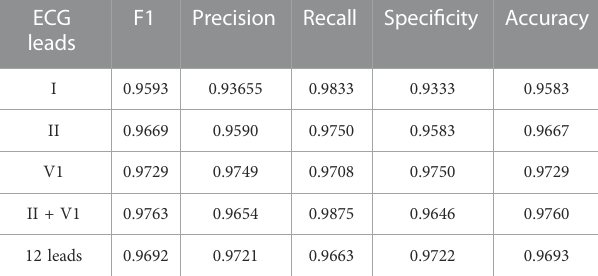
TABLE 3 Performance of AF classi fi cation based on different ECG